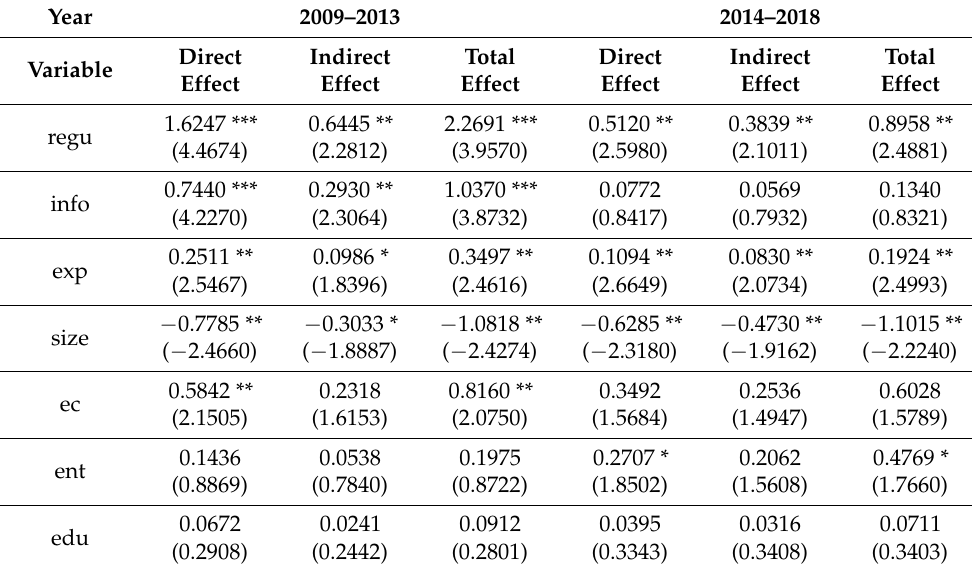
Table 9. Second robustness test